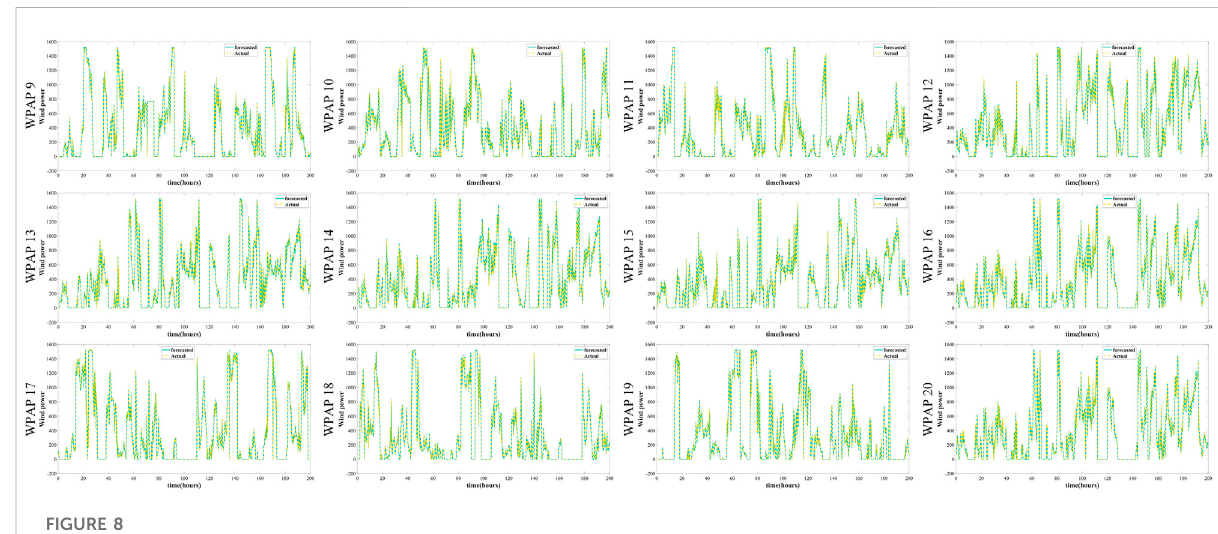
FIGURE 8 Transformer model migration based one-step power forecasting experimental results of NO.9-NO.20 WPAP.